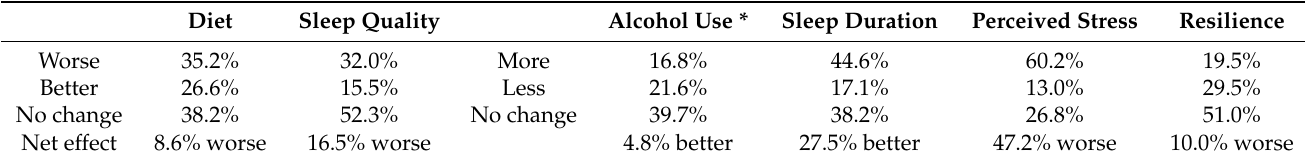
Table 5. Distribution of health behaviors, perceived stress, and resilience changes during the COVID-19